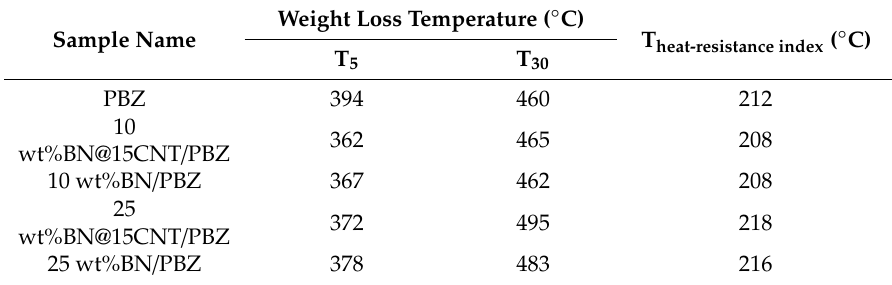
Figure 12. Figure 12. ( a ) TGA curves and ( b ) DTG curves of pristine PBz, BN/PBz composites and Table 3. Corresponding characteristic thermal data of TGA Table 3. Corresponding characteristic thermal data of TGA curves